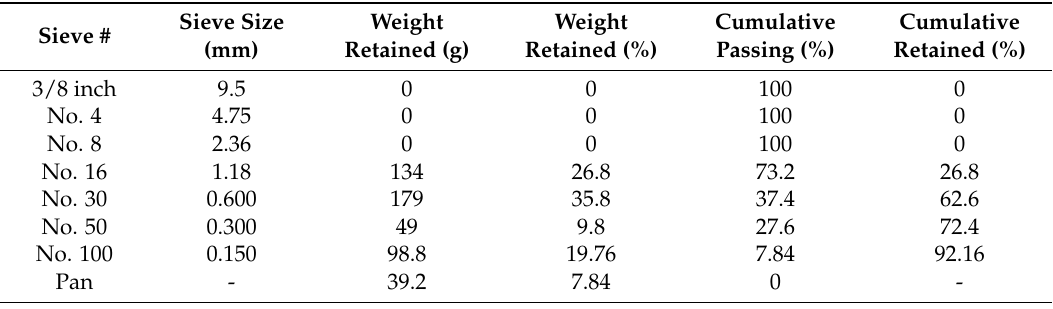
Table 1. Grain size distribution of fine aggregate (EN 196-1 and ISO 679:2009).